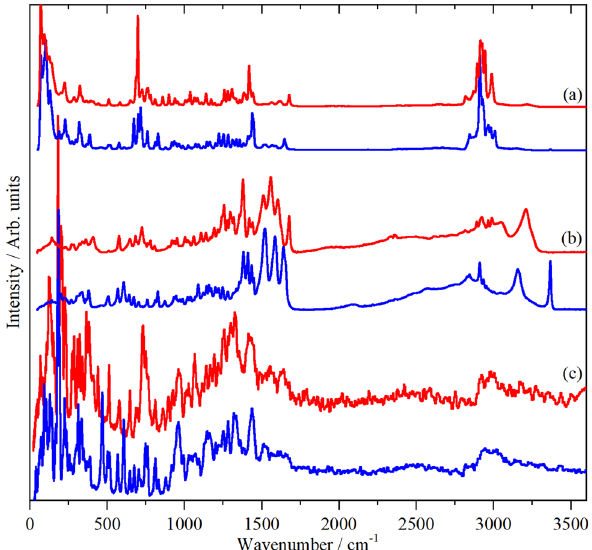
Figure 6. Vibrational spectra of dd-ll- (red) and dl-ld-methionyl-methionine (blue). ( a ) Raman, ( b ) infrared and ( c ) INS